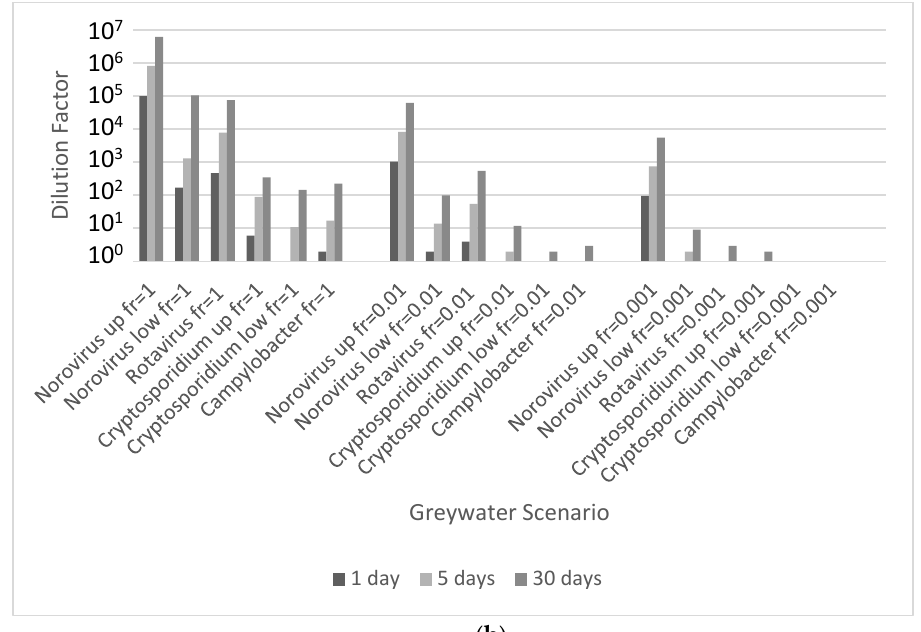
Figure 3. Target dilution factor for intrusion of ( a ) wastewater and ( b ) greywater (generated by 1000-person collection) to non-potable water that results in a 95th percentile annual risk of infection from non-potable domestic, indoor reuse equivalent to the benchmark (10 −4 ppy). The intrusion event duration was either 1, 5, or 30 days for two alternative fractions of the population exposed to the intrusion event (fr = 1, 0.01, or 0.001). The dilution factor is expressed as 1-part intrusion water: X parts total water. Both upper- (up) and lower- (low) bound dose-response presented.